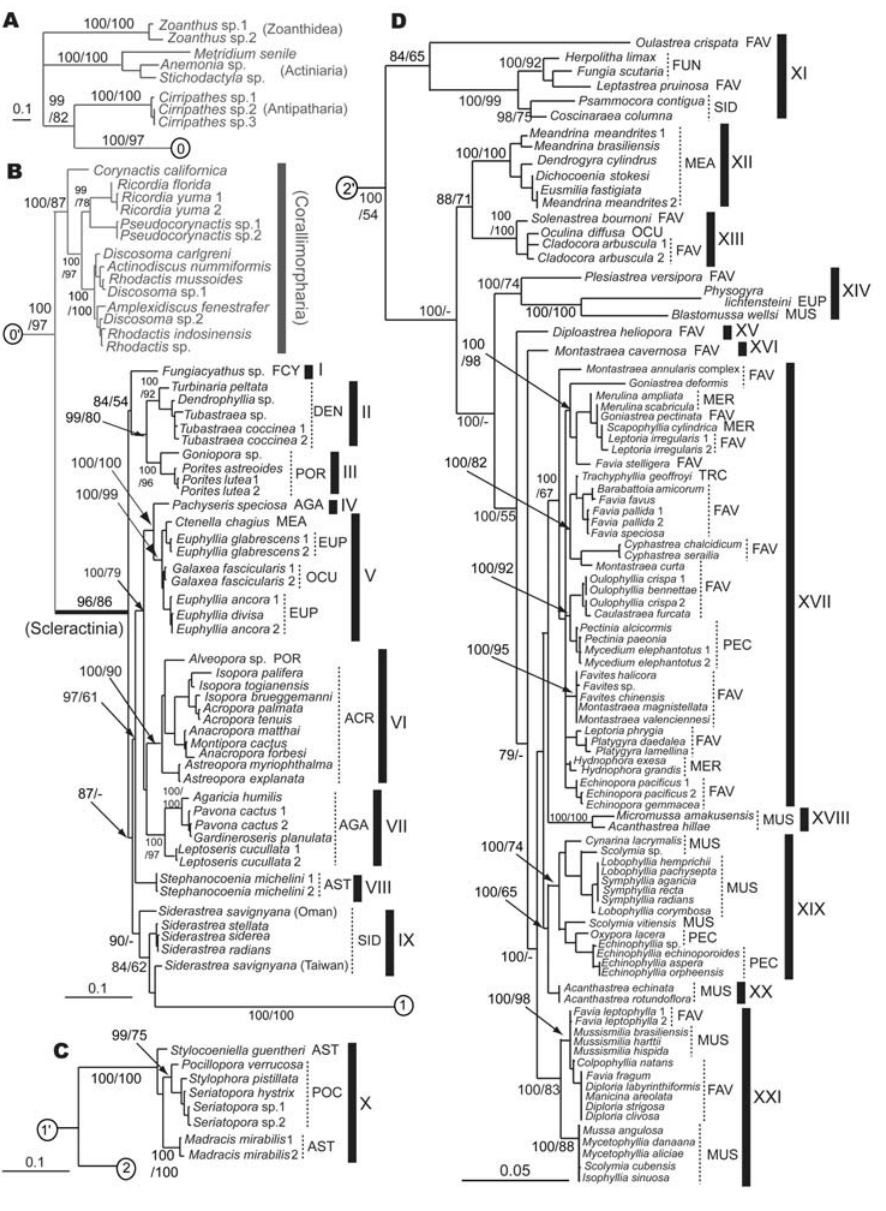
Figure 1. Phylogenetic relationships among scleractinian (mostly zooxanthellate) corals and outgroups. Topology was inferred by Bayesian analysis, based on combined mitochondrial cox1 and cob DNA sequences. Numbers on main branches show percentages of Bayesian probability ( . 70%) and bootstrap values ( . 50%) in ML analysis. Dashes mean bootstrap values , 50% in ML. Numbers in circles show the connection of trees from A to D; for example, 1 9 in circle continues directly from 1 in circle. Bars in black indicate possible new family level groupings (see also Supporting Online Information Table 2). Numbers (1, 2) following species names indicate that different colonies of the species had different haplotypes. A. outgroups, B. complex corals and corallimorpharians, C. the family Pocilloporidae, D. robust corals. ACR: Acroporidae, AGA: Agariciidae, AST: Astrocoeniidae, DEN: Dendrophylliidae, EUP: Euphylliidae, FAV: Faviidae, FCY: Fungiacyathidae, FUN: Fungiidae, MEA: Meandrinidae, MER: Merulinidae, MUS: Mussidae, PEC: Pectiniidae, POC: Pocilloporidae, POR: Poritidae, OCU: Oculinidae, SID: Siderastreidae, TRC: Trachyphylliidae.